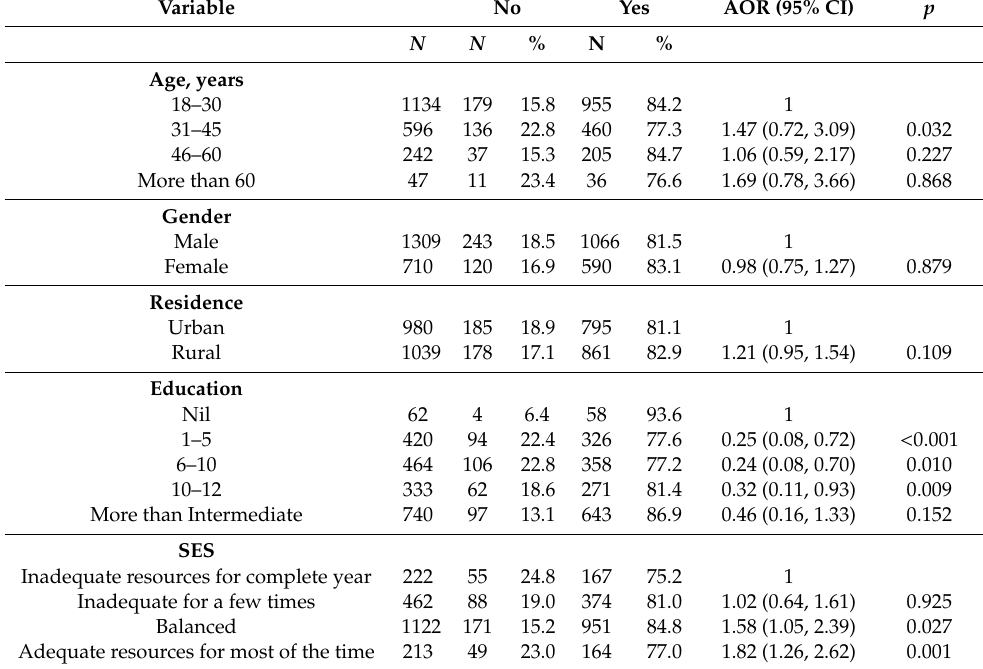
Table 5. Demographic relationship with attitude of general population (“Will you seek eye treatment for the